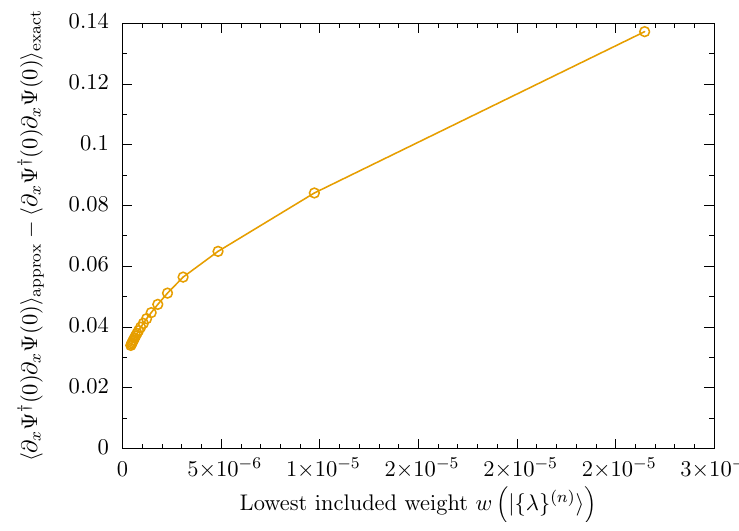
Ψ ( 0 ) in Ψ † ( 0 ) ∂ x x = 10 eigen- f